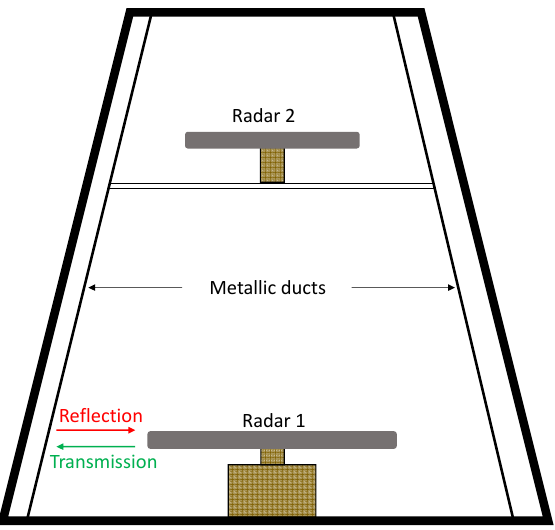
Figure 11. Representation of the profile view of radars mounted inside a